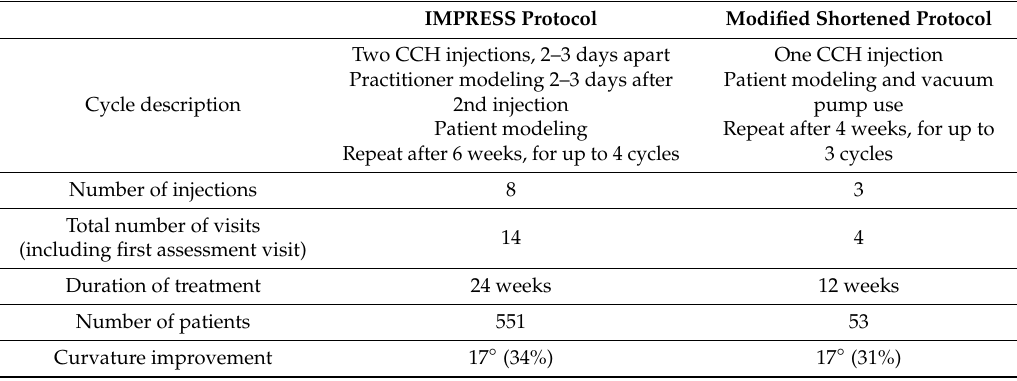
Table 2. Comparison of Protocols for CCH